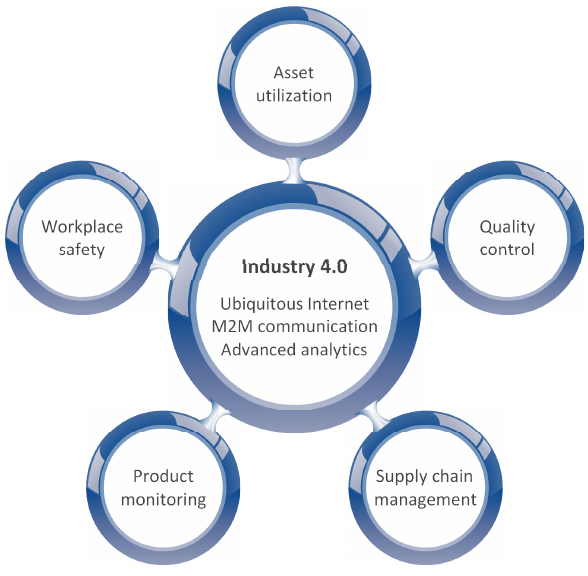
Figure 1. Enabling technologies and application domains in Industry 4.0.